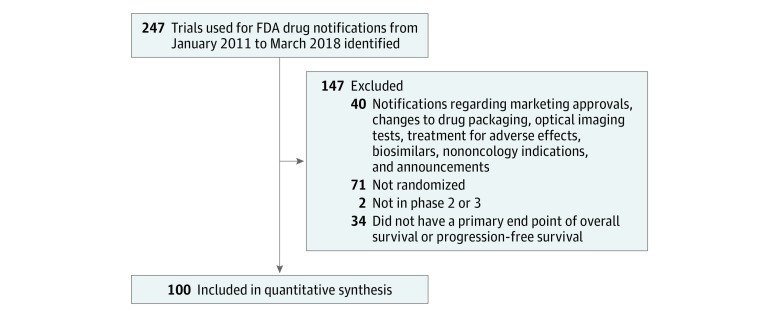
Flow Diagram of Included StudiesFDA indicates Food and Drug Administration.